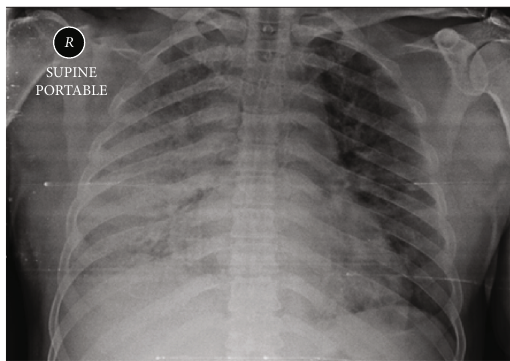
Figure 1: Chest X-ray of the patient from the day he was admitted to the hospital.